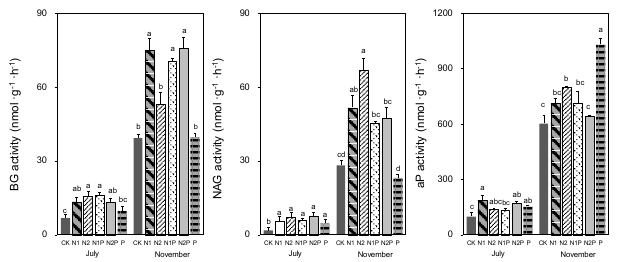
Figure 2. Responses of soil enzyme activities to N and P additions in Chinese fir plantations in July and November (different lower- case letters in different bars indicate significant differences when P